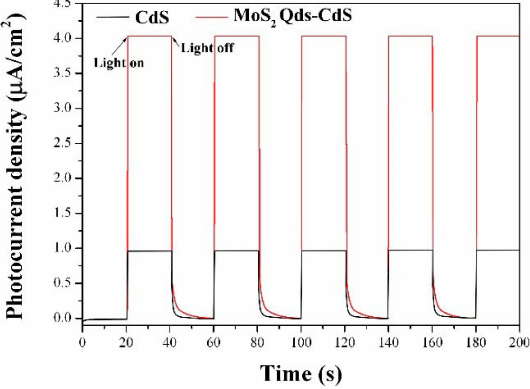
Figure 9. Transient photocurrent density versus time plotted for CdS and MoS 2 QDs/CdS in 0.2 M Na 2 SO 4 electrolyte under visible light